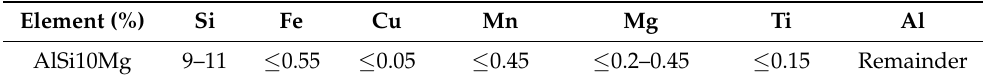
Table 1. AlSi10Mg chemical